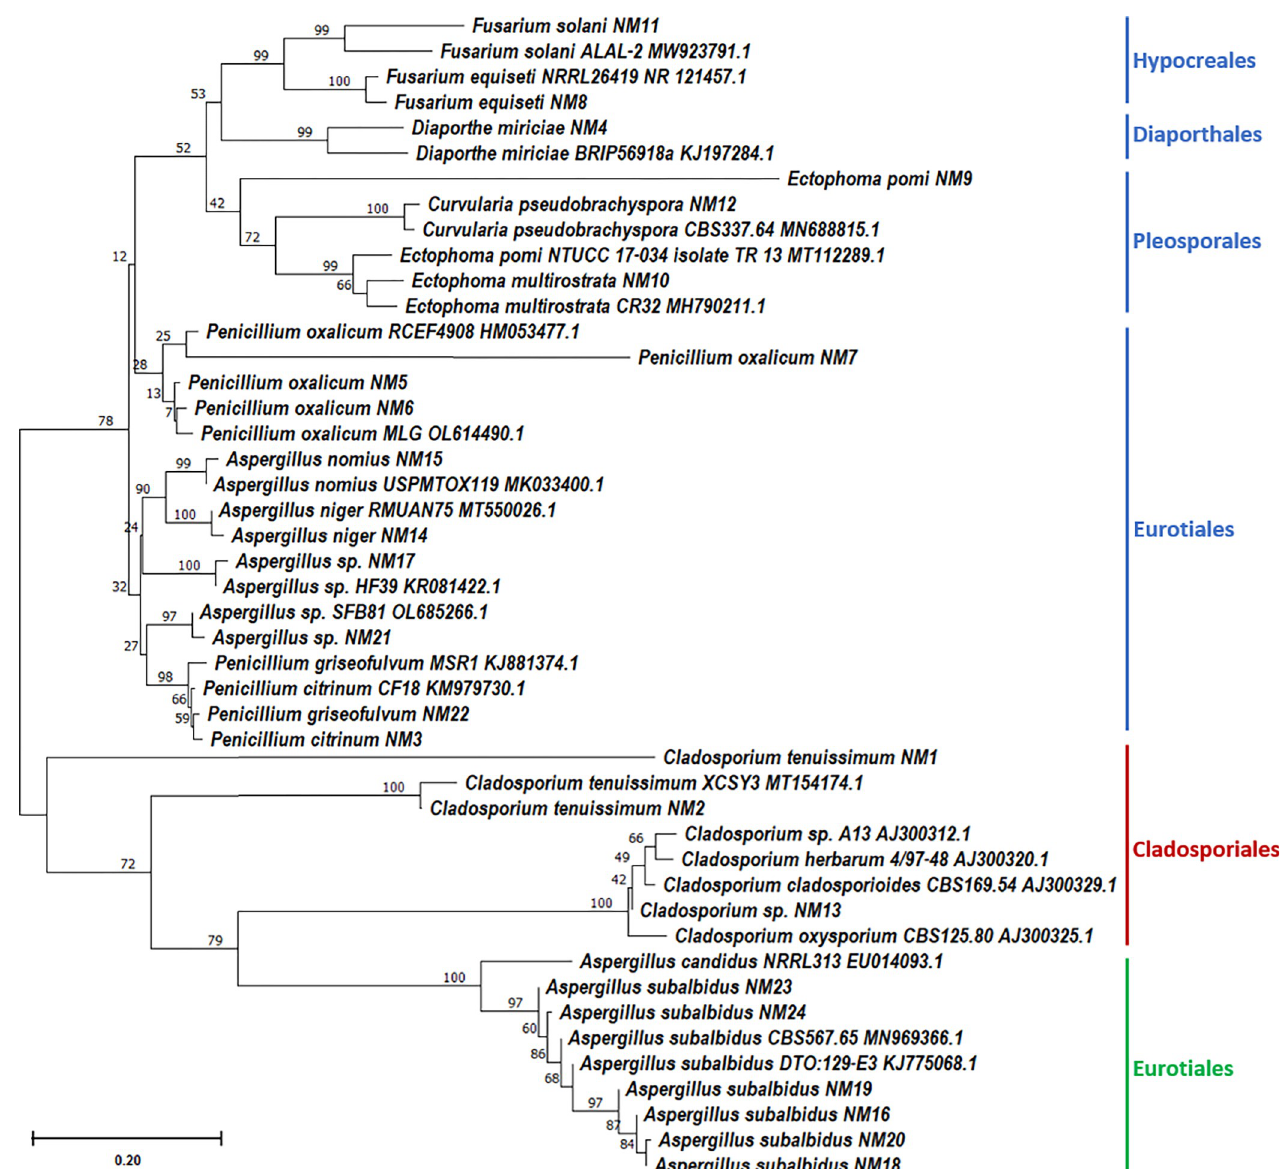
Fig 3. Phylogenetic analysis of the isolated fungi. An unrooted phylogenetic tree was generated using the neighbor-joining method based on comparisons of the ITS ribosomal DNA sequences (blue clade), actin (red clade,) and the β -tubulin gene (green clade) of fungal isolates and their closest phylogenetic relatives. Percentages of bootstrap sampling derived from 1000 replications are indicated by the numbers on the